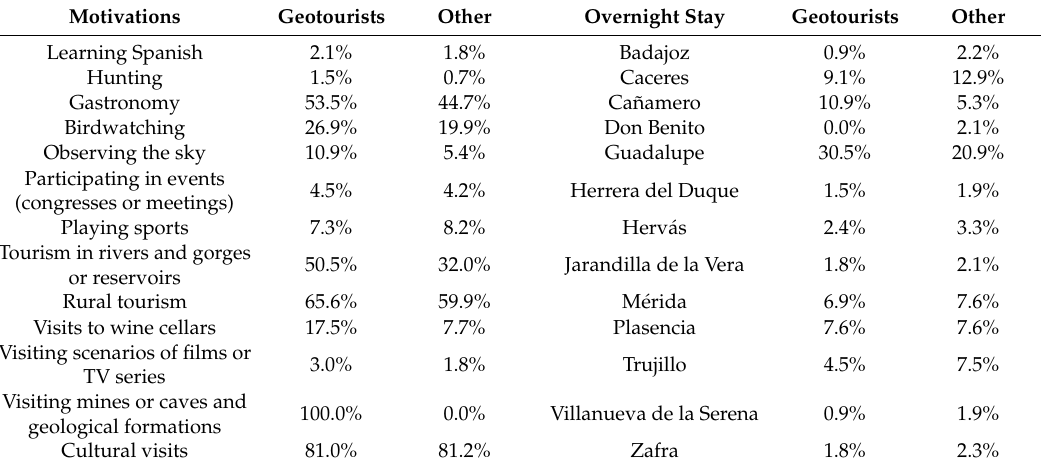
Table 8. Motivations and overnight stay locations of visitors to the